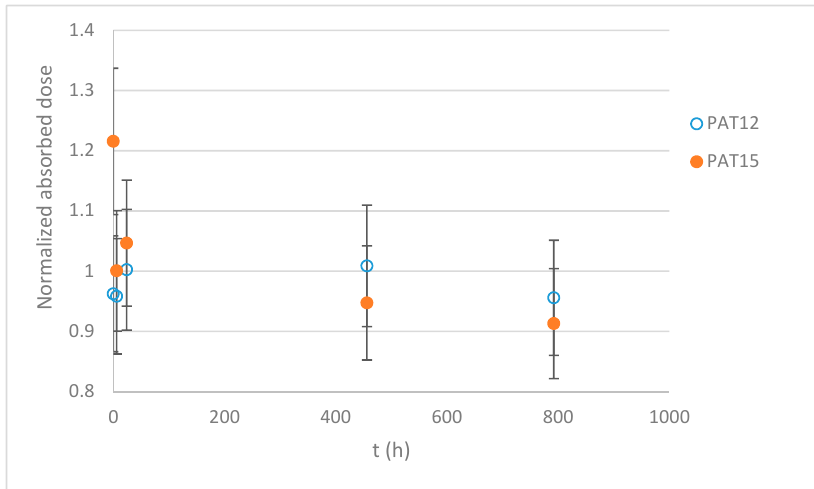
Figure 5. Normalized absorbed dose versus time.